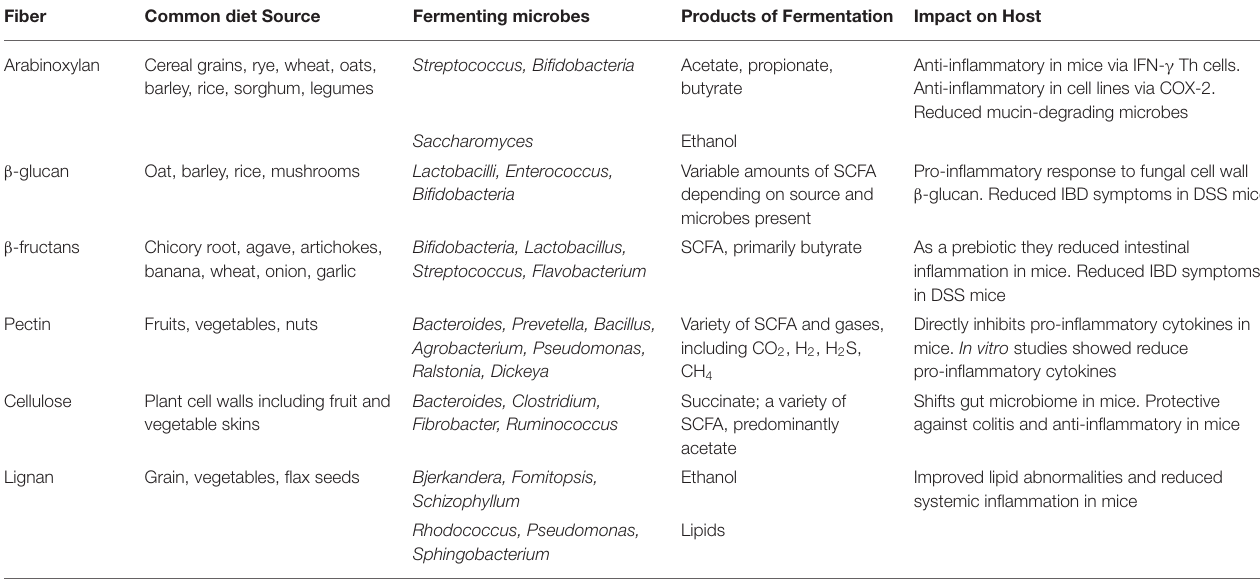
TABLE 1 | Summary of sources, fermentation, products, and potential impacts of dietary